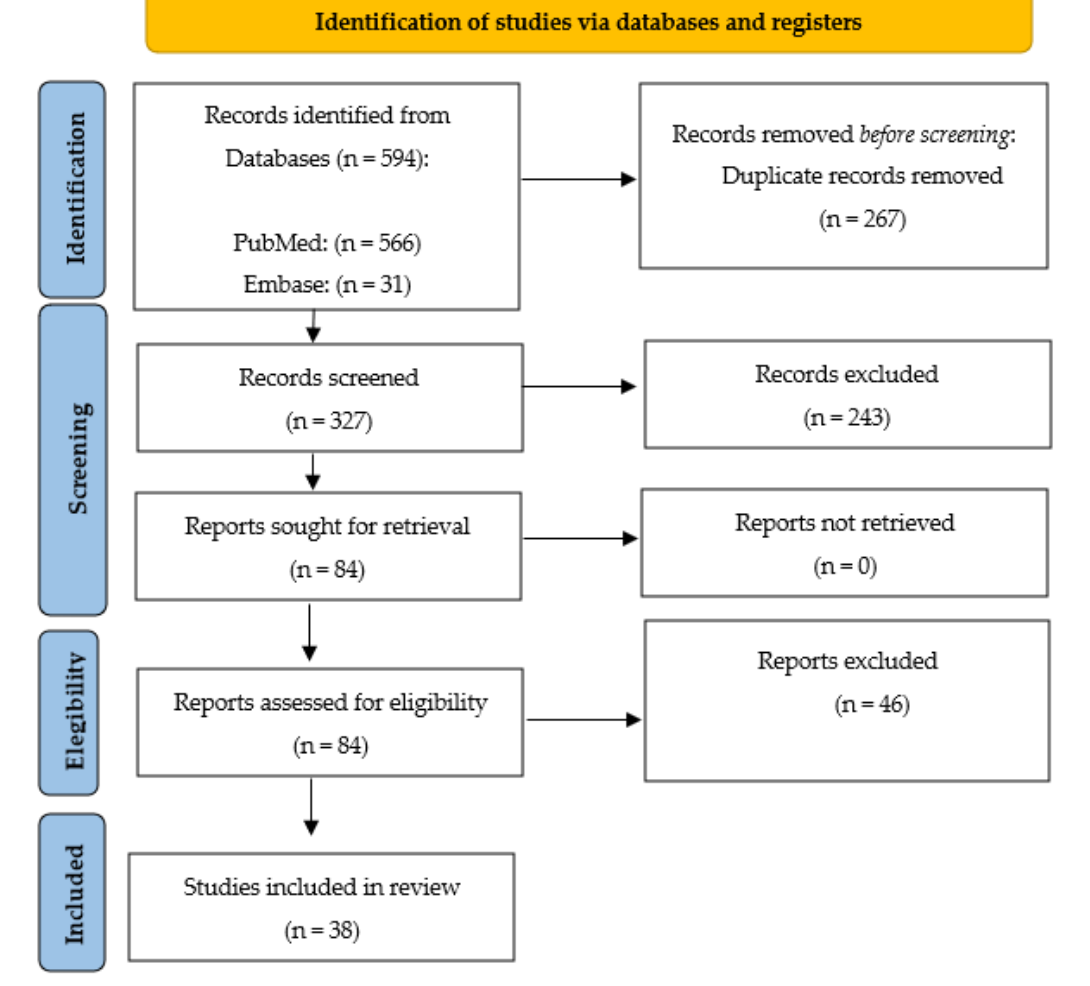
Figure 1. PRISMA (Preferred Reporting Items for Systematic Reviews and Meta-Analyses) flow diagram [7].